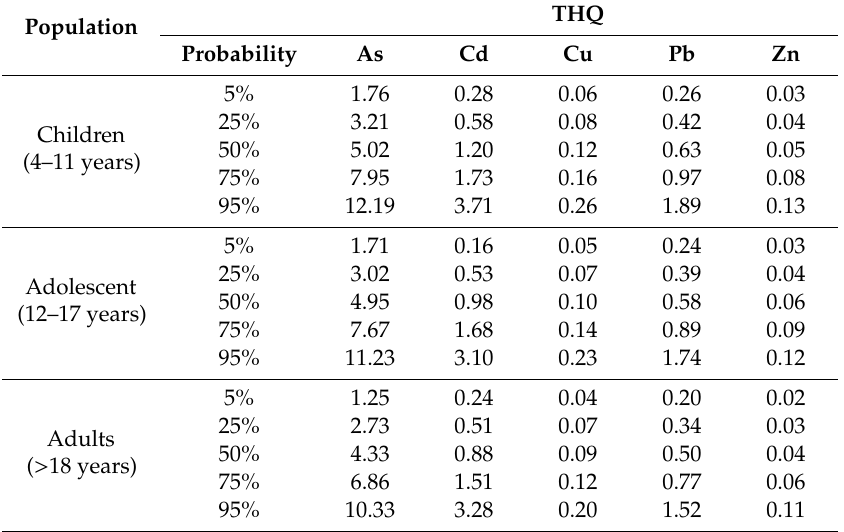
Table 3. Target hazard quotients (THQs) of di ff erent populations in the study area.